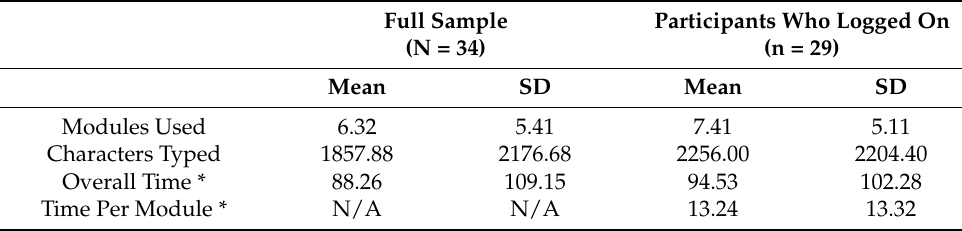
Table 2. Usage data from Willow